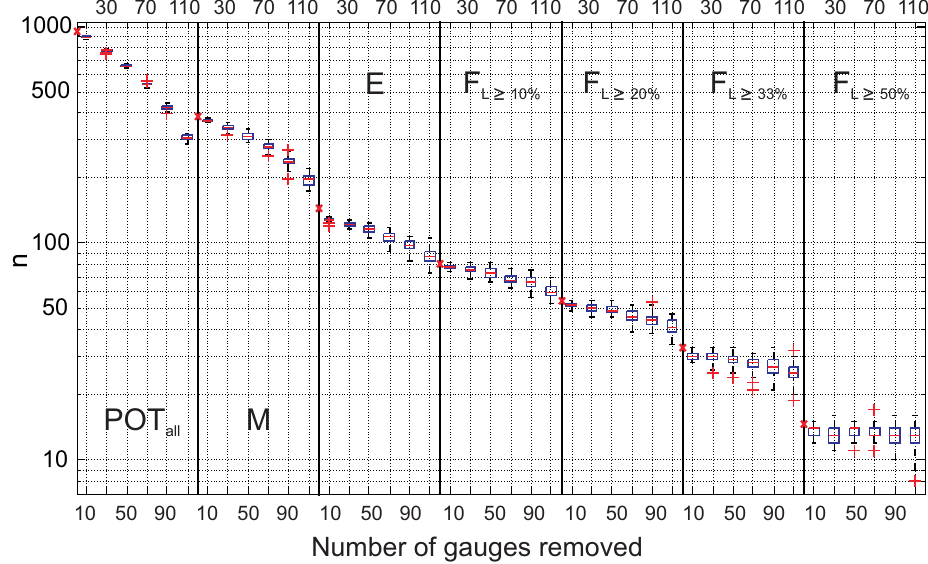
Fig. 11. Bootstrap results for the various steps in event identification. Shown is the number of all identified peaks over threshold (POT all ) , the redundancy free number of peaks over threshold ( M ), the total number of identified flood events E , and the number of trans-basin floods F that exceeded a particular spatial extent L , respectively, against the number of removed gauges. The notation of the box plots is the same as in Fig.